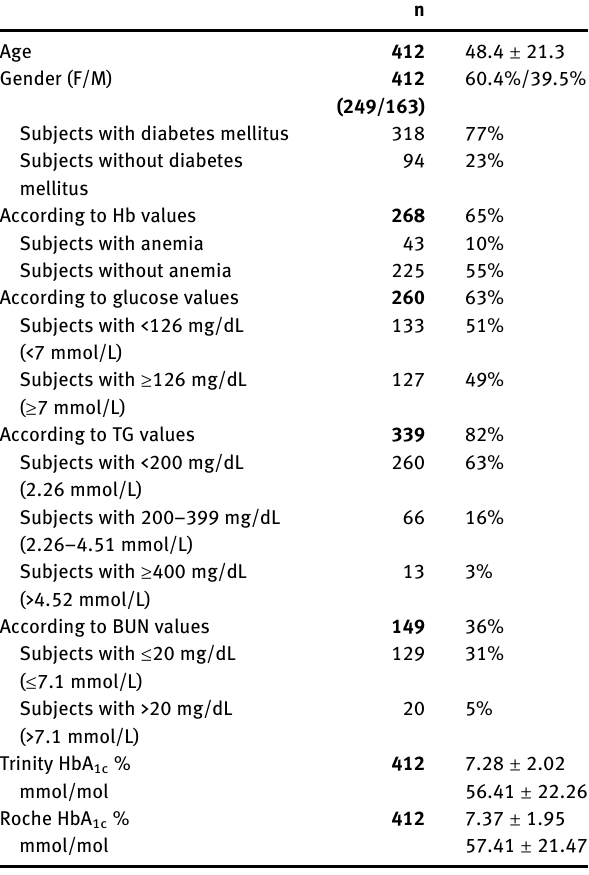
Table  : Distribution of patients according to age, sex characteris- tics and biochemical data.